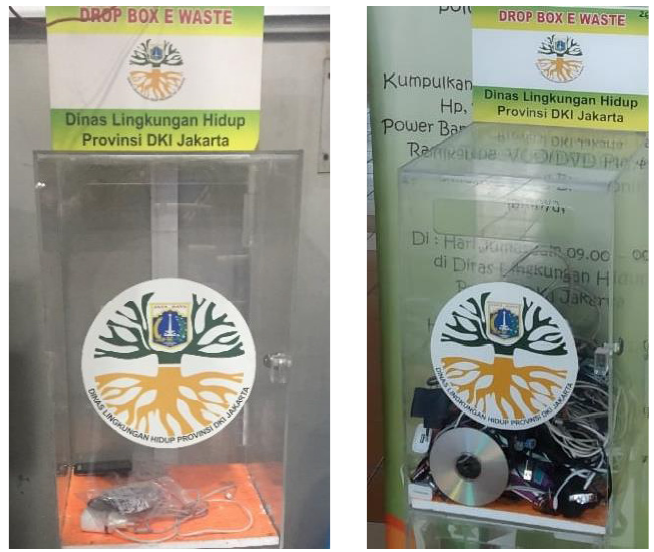
Fig. 5: E-waste drop boxes in Jakarta